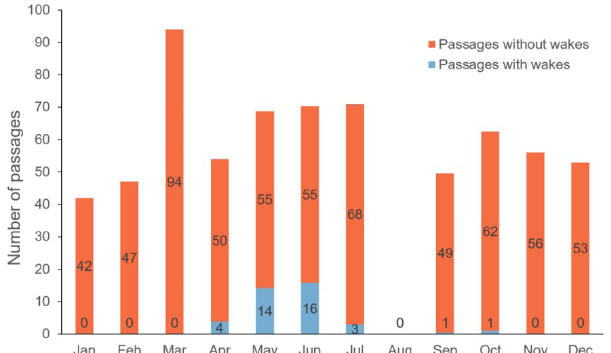
Figure 9. Seasonal distribution of ship passages for the satellite scenes with < 23% cloud cover, for the period April 2013 to De- cember 2018. The data labels in the stacked bar indicate the number of passages in each category. As some months have more than one analysed scene, the total number of ship passages for each month was divided by the number of analysed scenes to get an average number of passages per scene for each month. August had no scenes with < 23% cloud cover and therefore has no